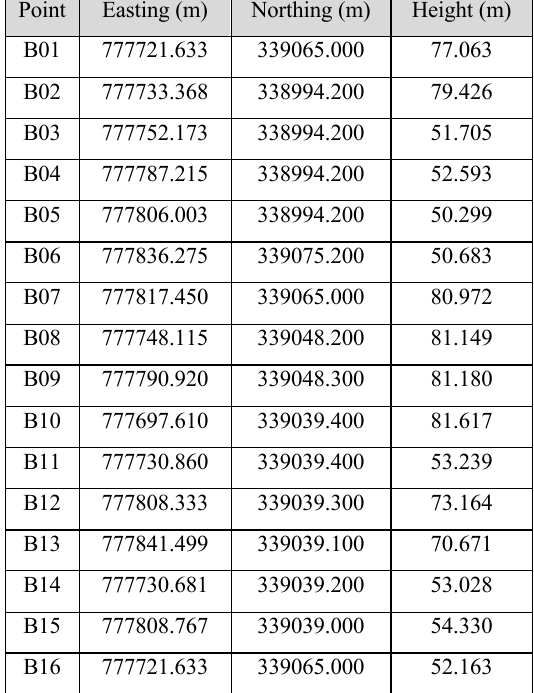
Table 1. Results of Control Points using Conventional